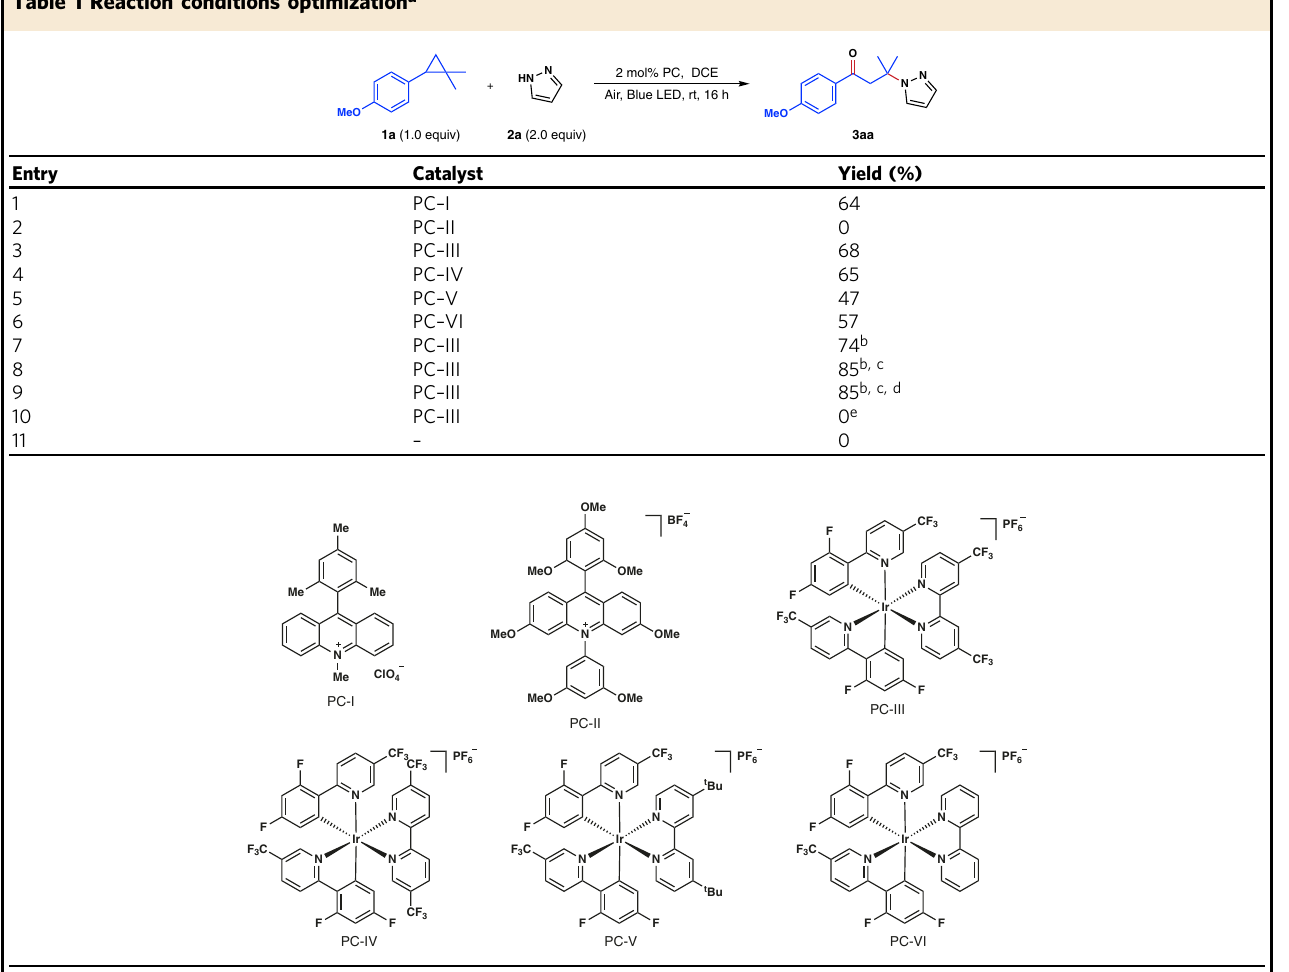
Table 1 Reaction conditions optimization